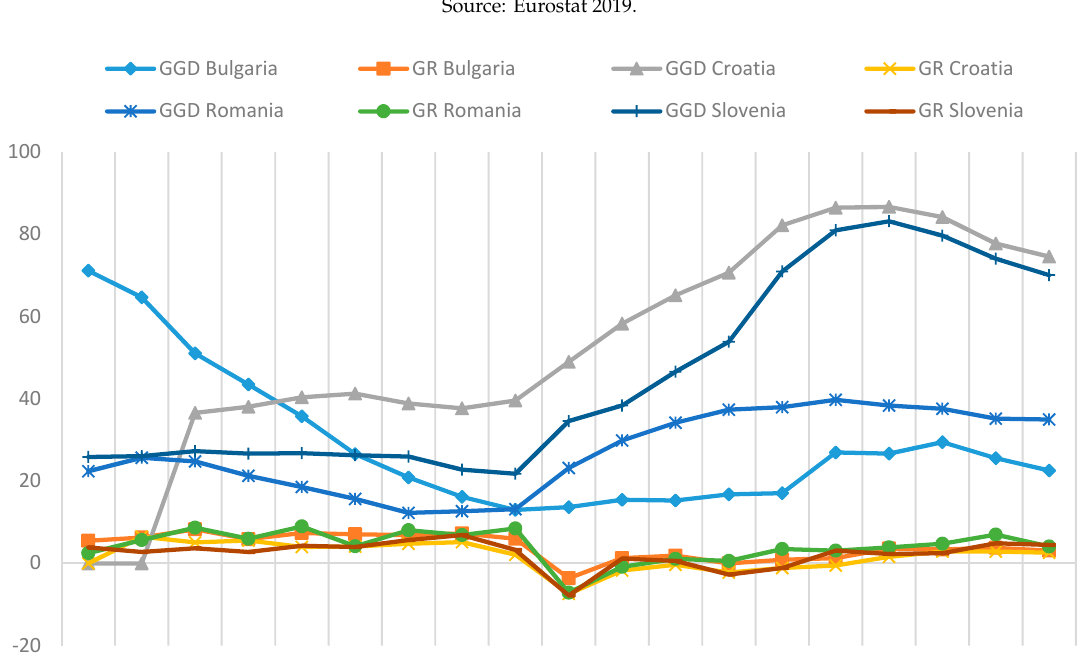
Figure 6. The Balkan countries’ GGD percentage of GDP versus growth rate percentage change from previous year, 2000–2018; Source: Eurostat.